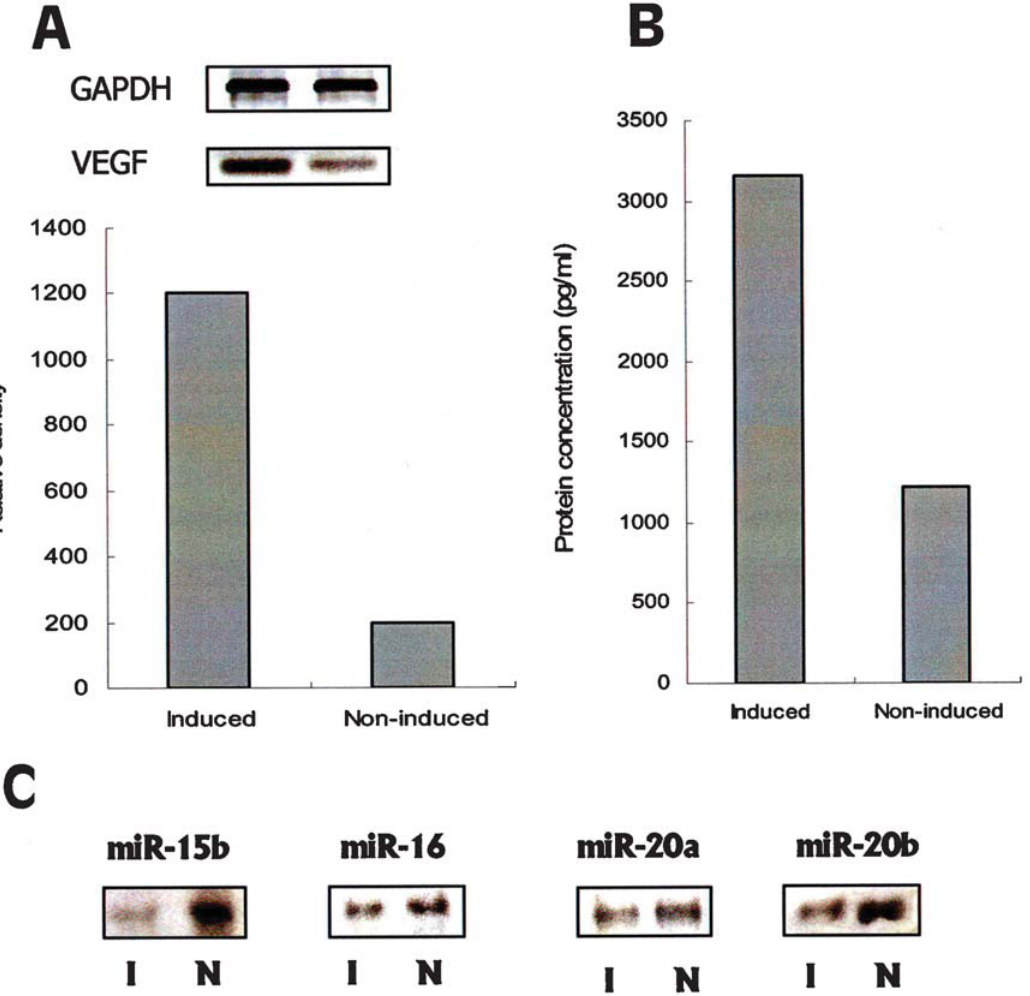
Figure 2. VEGF and miRNA expression in CNE cells. Cell lysate and culture medium from DFOM-induced CNE cells were collected. RT-PCR (A) and ELISA (B) assays were performed to determine VEGF expression at the mRNA and protein levels. CNE cells without DFOM treatment were used as a control. The mir Vana TM miRNA Detection procedure was used to validate miRNA chip data. miR-15b, miR-16, miR-20a , and miR-20b were down- regulated in hypoxia induced CNE cells (C). I: induced, N: